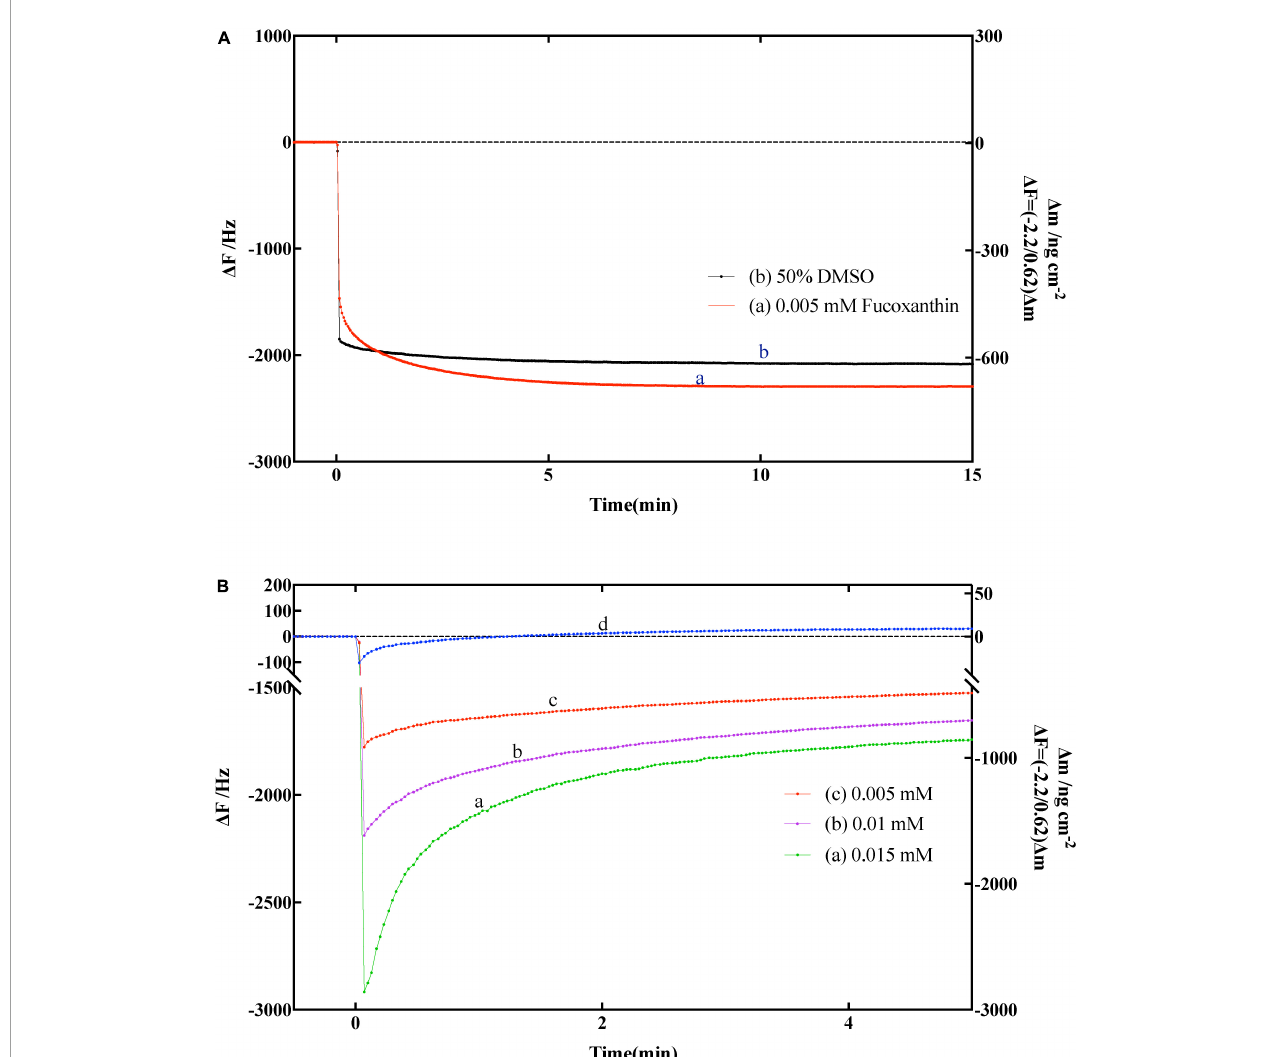
FIGURE4 (A) Effect of fucoxanthin on frequency changes of the amylose–avidin-immobilized quartz crystal microbalance-admittance (QCM-A). (a) 0.005 nM fucoxanthin in 50% DMSO, (b) 50% DMSO solution. (B) Effect of different concentrations fucoxanthin for α -amylase on frequency changes of the amylose–avidin-immobilized QCM-A. (a–c) Different concentrations fucoxanthin in 50% DMSO (0.005, 0.01, 0.015 mM), (d) responding to the addition of 1 mg mL − 1 α